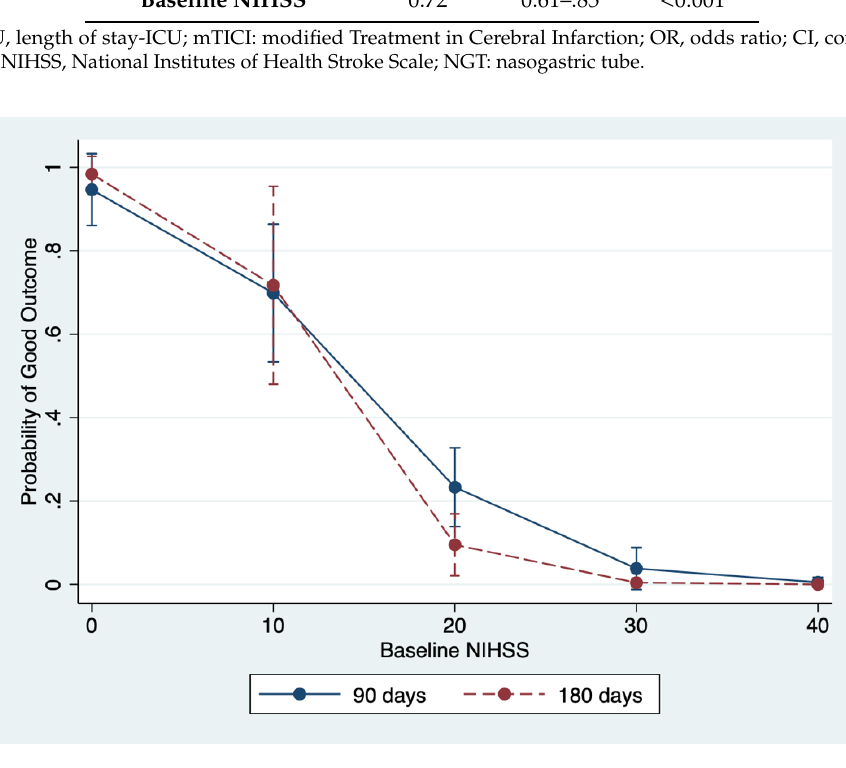
Figure 2. Marginal effect of baseline NIHSS on the probability of a good outcome at 90 days (blue line) and 180 days (red line); the other covariates of the multivariable model are kept fixed. A good outcome is defined as eventual return to home or discharge to assisted living (modified Rankin scale (mRS) < 2). Table 2. Multivariate logistic regression model for predictors of 90-day good outcome (mRS 0–2). Var.